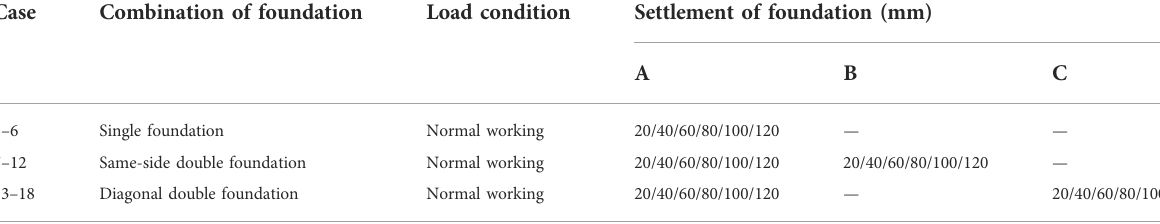
TABLE 3 Combinations of the uneven foundation settlement on the SA-3 shaft sinking